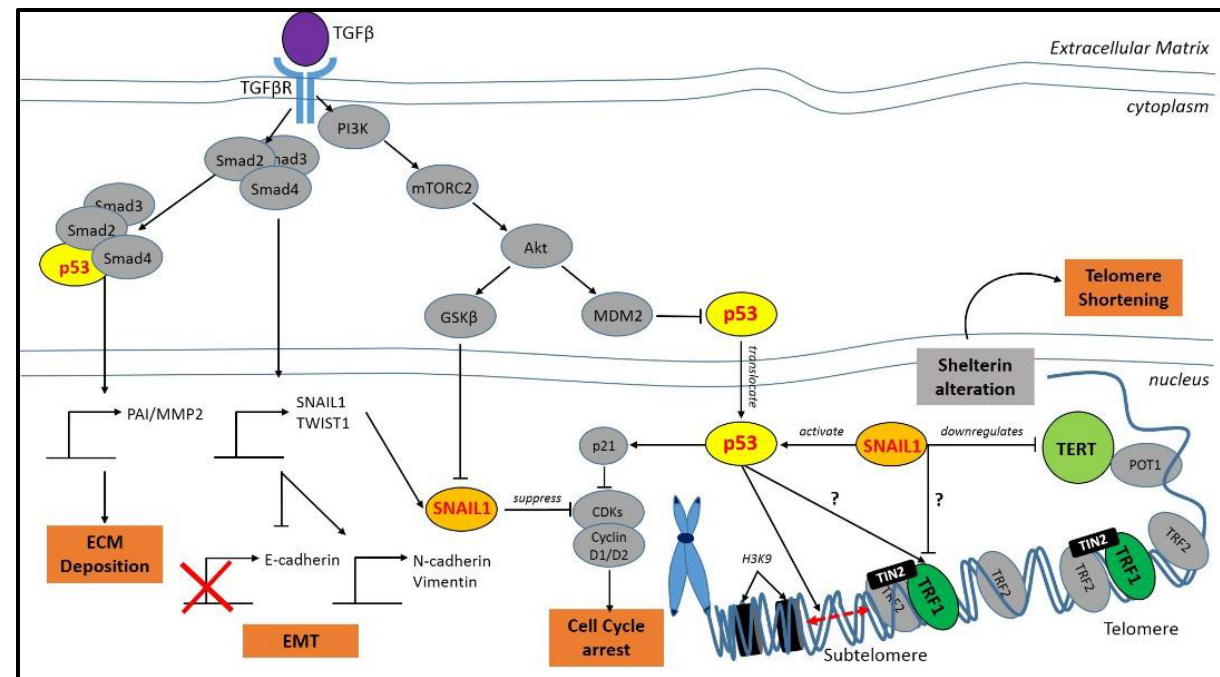
Figure 2. A schematic diagram of the interconnection between EMT and TRF1/2. The cross sign indicates downregulation of the protein and the question mark indicates that the pathway or regulation is still unknown. Apart from EMT response, activation of the transforming growth factor-β (TGF-β) signaling pathway coordinates various critical events such as extracellular matrix (ECM) deposition and cell cycle arrest. It is predicted that EMT is also involved in telomere shortening via SNAIL1–TERT–TRF1 interaction.